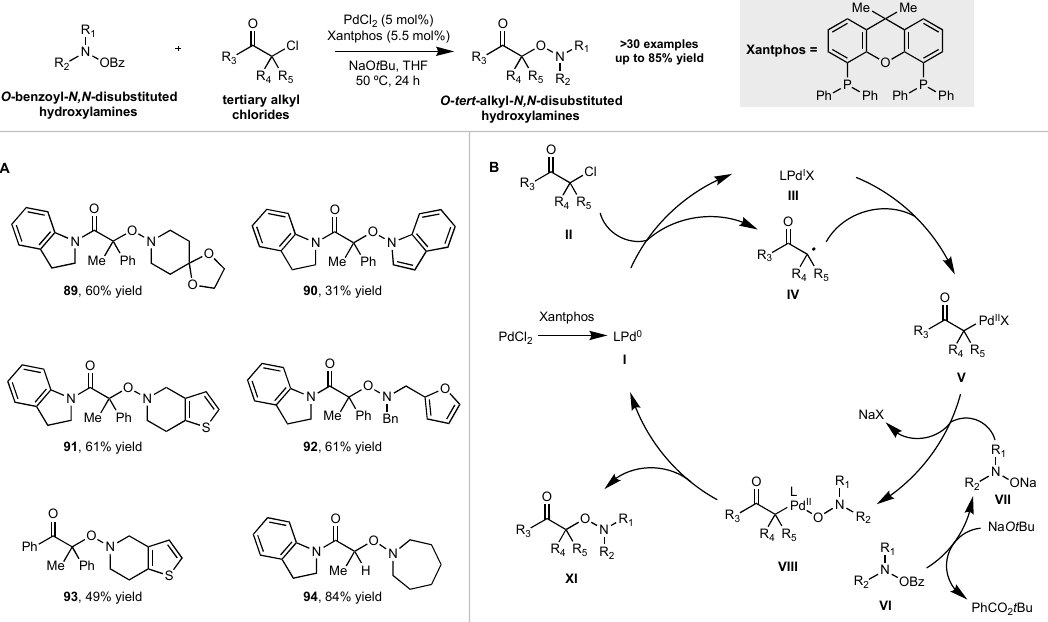
Scheme 8. Shao, Xiao, and Deng(cid:31)s synthesis of O-tert -alkyl- N , N -disubstituted hydroxylamines through palladium catalysis. ( A ) Selected examples of the transformation. ( B ) Proposed catalytic